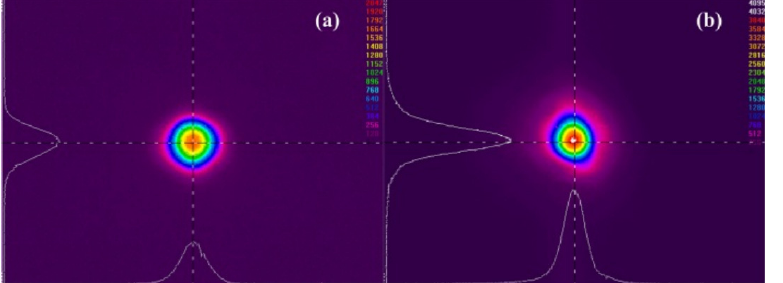
Figure 16. Far ‐ field pattern of the combined beam in ( a ) a low ‐ power case and ( b ) a full ‐ power (3 kW) case in the dual ‐ grating SBC system. (3 kW) case in the dual-grating SBC system.